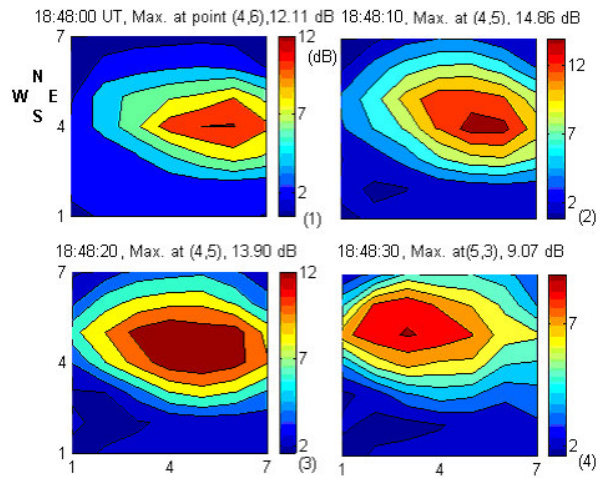
Fig. 7. Normalised mean of wavelet power spectrum for frequencies between 10–300mHz (10mHz step) for 4 types of spike events. Data bars are normalised to the mean of maximum power absorption and are dimensionless.